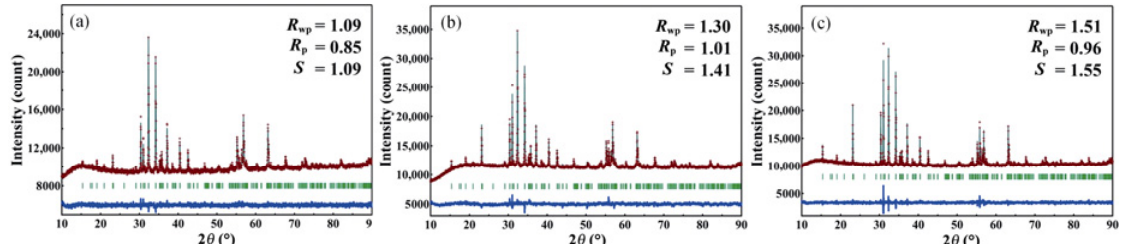
Fig. 2 Refined XRD patterns by Rietveld method for sintered SrM specimens: (a) T s = 1100 ℃ , (b) T s = 1150 ℃ , and (c) T s = 1250 ℃